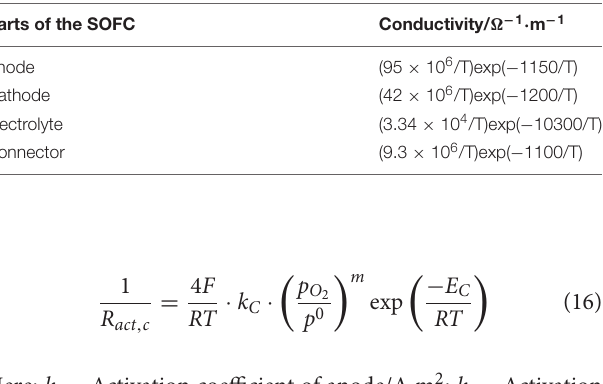
TABLE 1 | Conductivity of SOFC components (Braun, 2002).